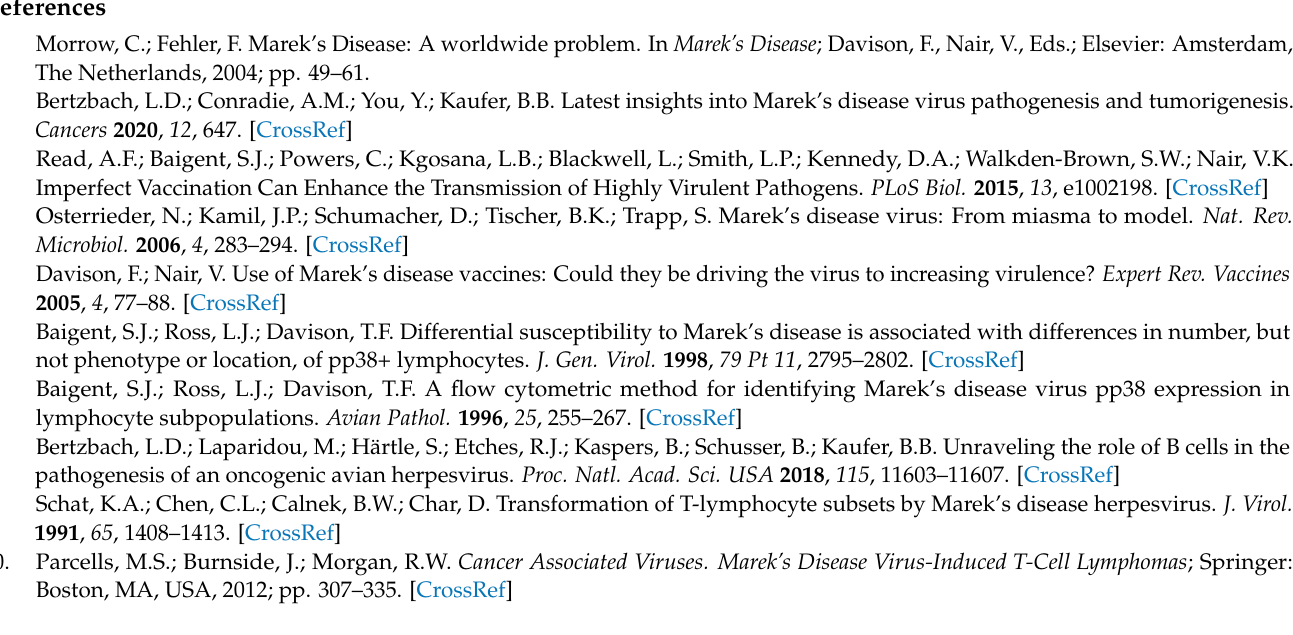
Figure S2: MDV integration in the MDV tumor cell line MSB-1 and in primary MDV tumor